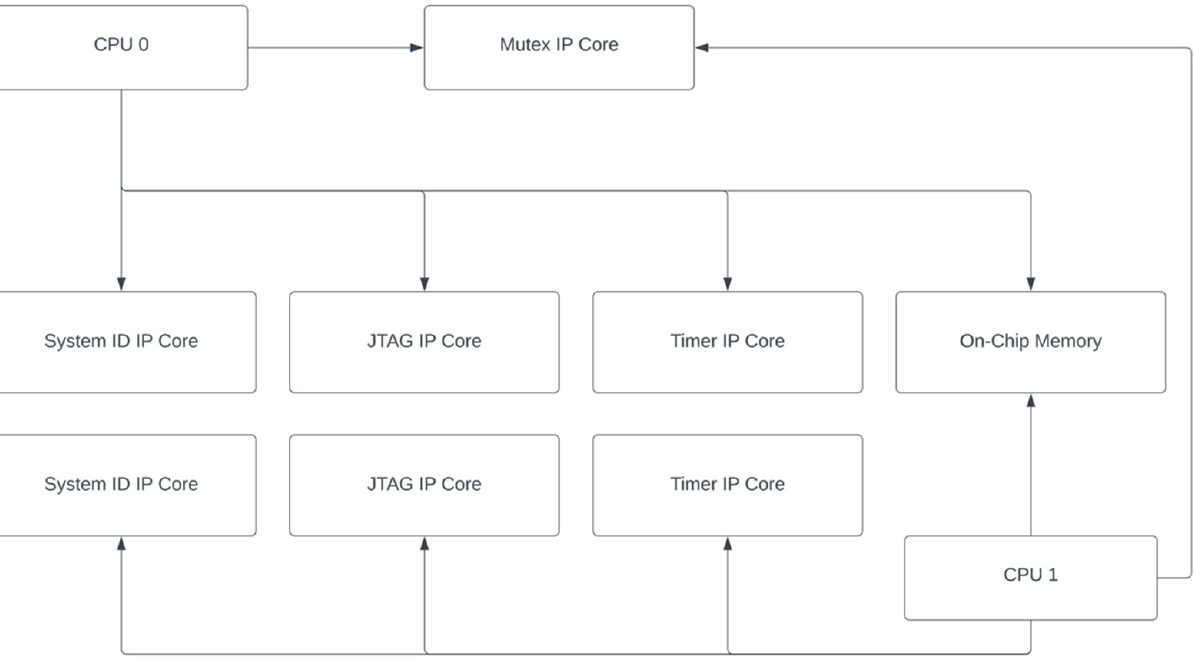
Figure 11. A diagram of a multi-NIOS system with peripherals.